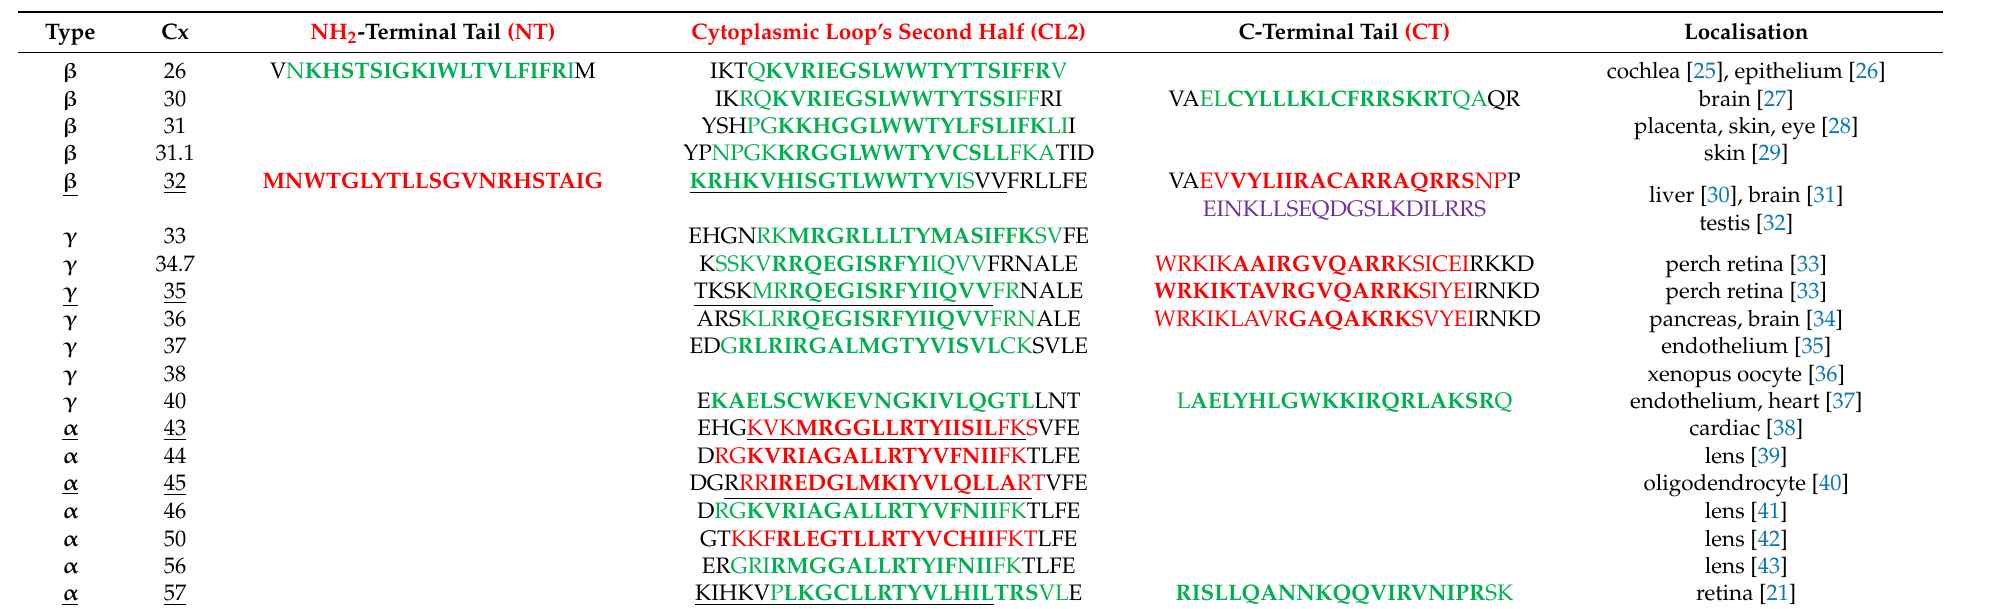
Table 1. Predicted and/or identified CaM binding domains of Cx isoforms.